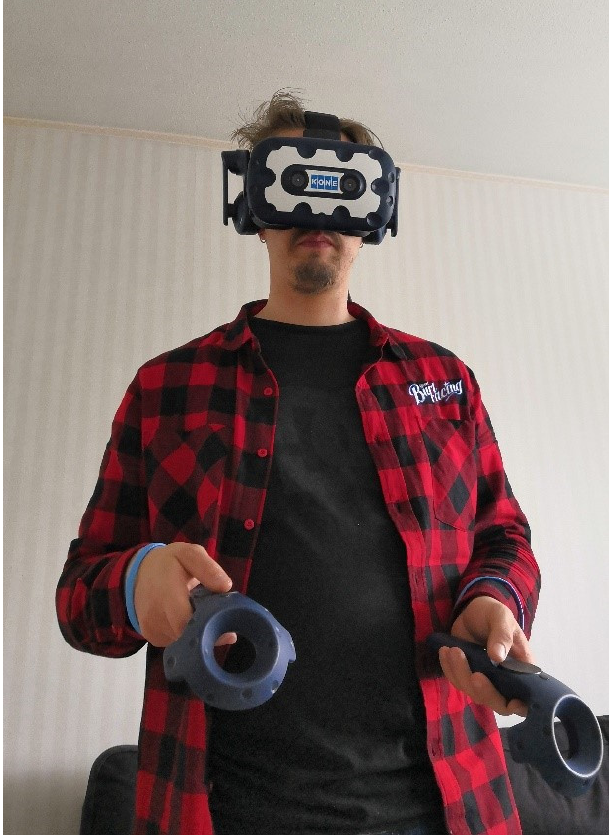
Figure 1. A participant attending a test session at a remote assistant’s home in Case 1.